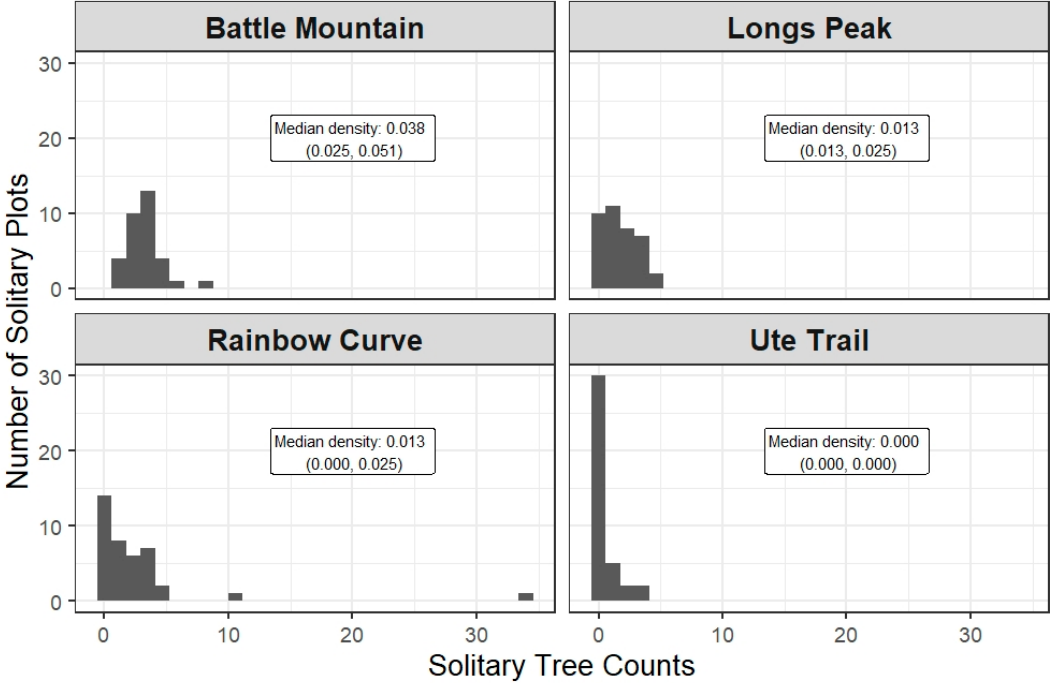
Figure 4. Plots were binned according to the number of solitary trees within each. Plots were 78.54 m 2 in area. The median density of solitary trees (trees / m 2 ) for each site is shown in the text box with 95% confidence intervals. Where confidence intervals do not overlap, differences are significant at the α = 0.05 threshold.